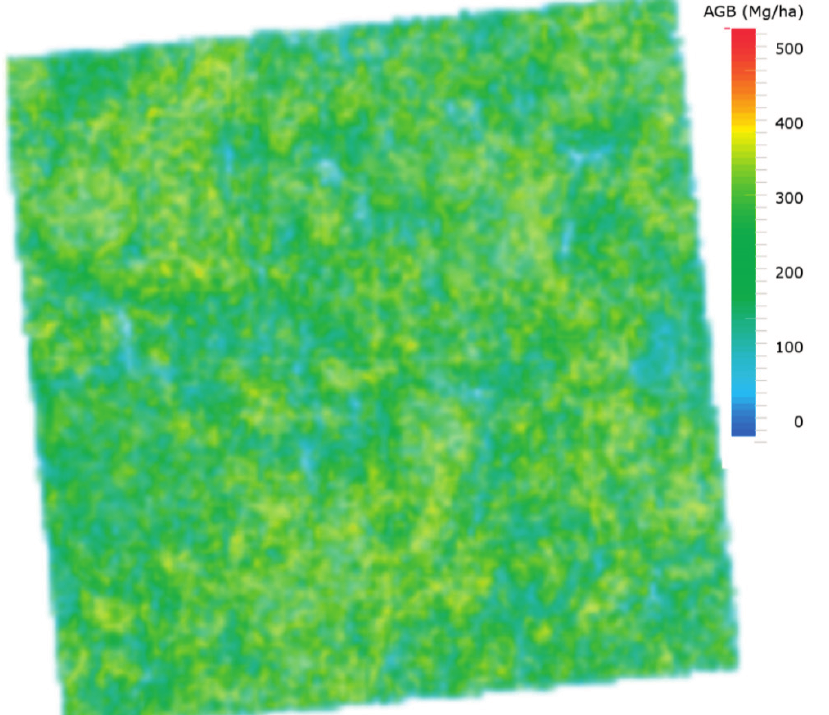
Figure 9. Estimation of biomass using the two predictors selected by stepwise